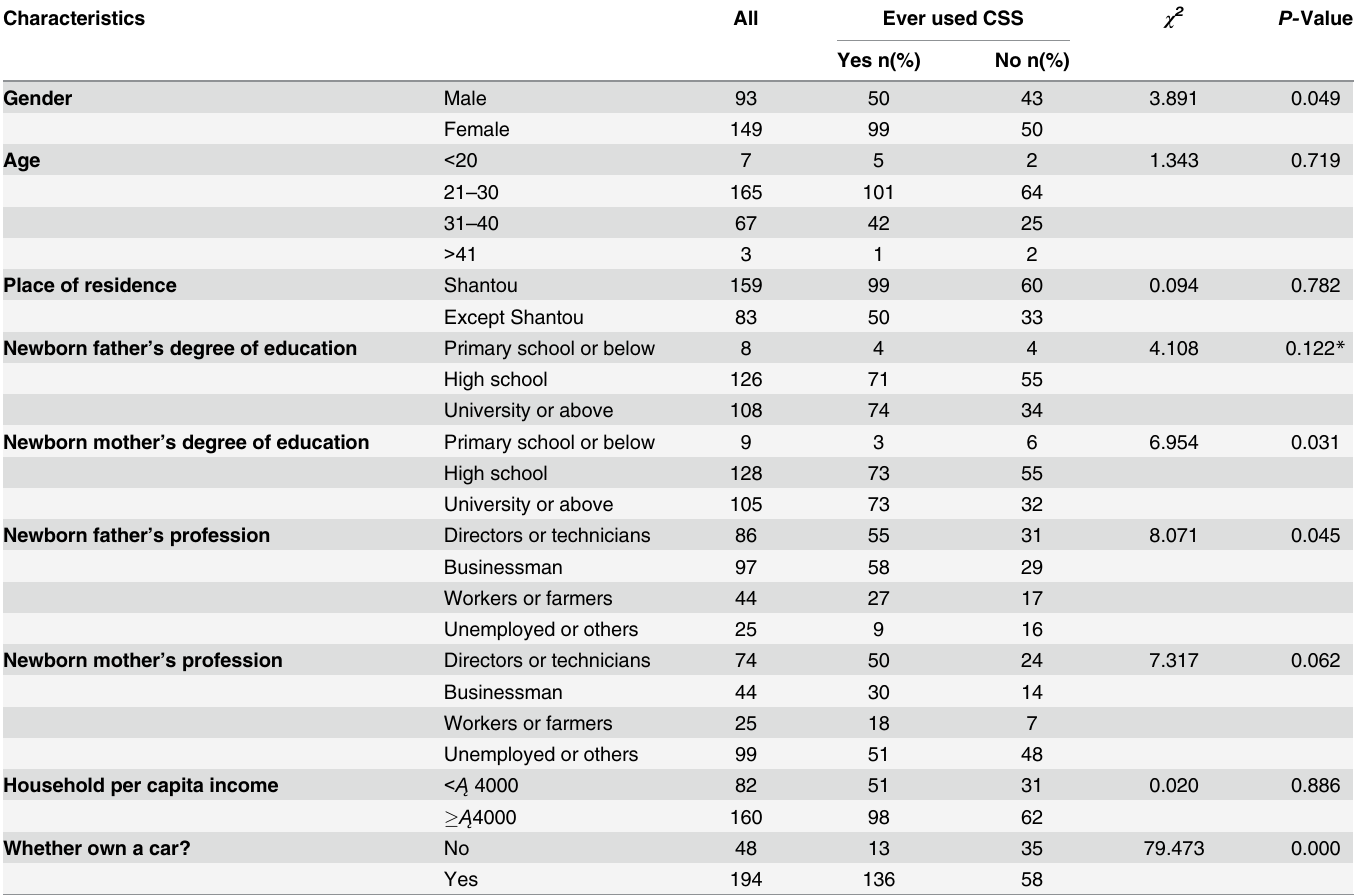
Table 1. Demographic Characteristics of Surveyed Newborn